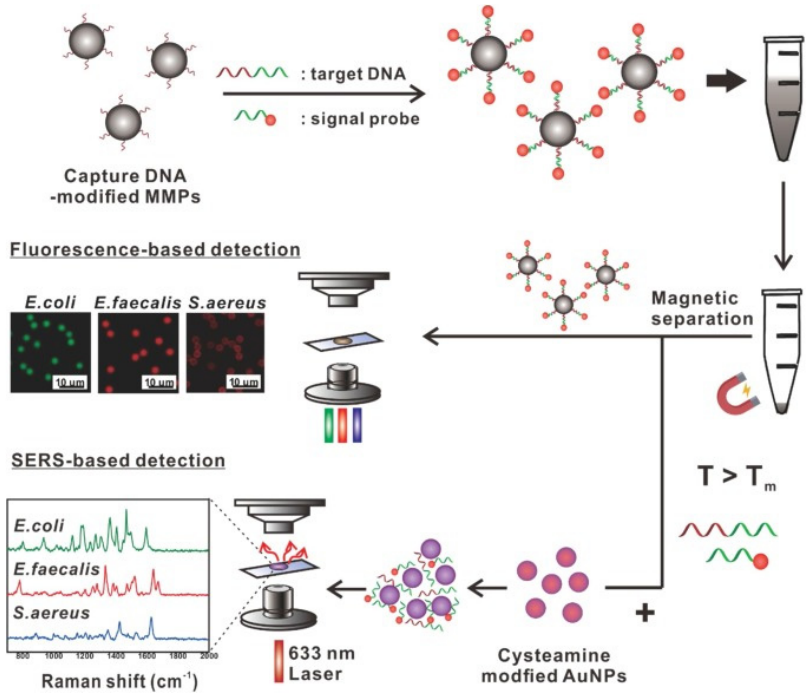
Figure 3. The fluorescence intensity of MMPs and the released signal from probes were measured with fluorescence and the SERS-based detection methods (reproduced with permission from [50]; published by Elsevier, 2021).